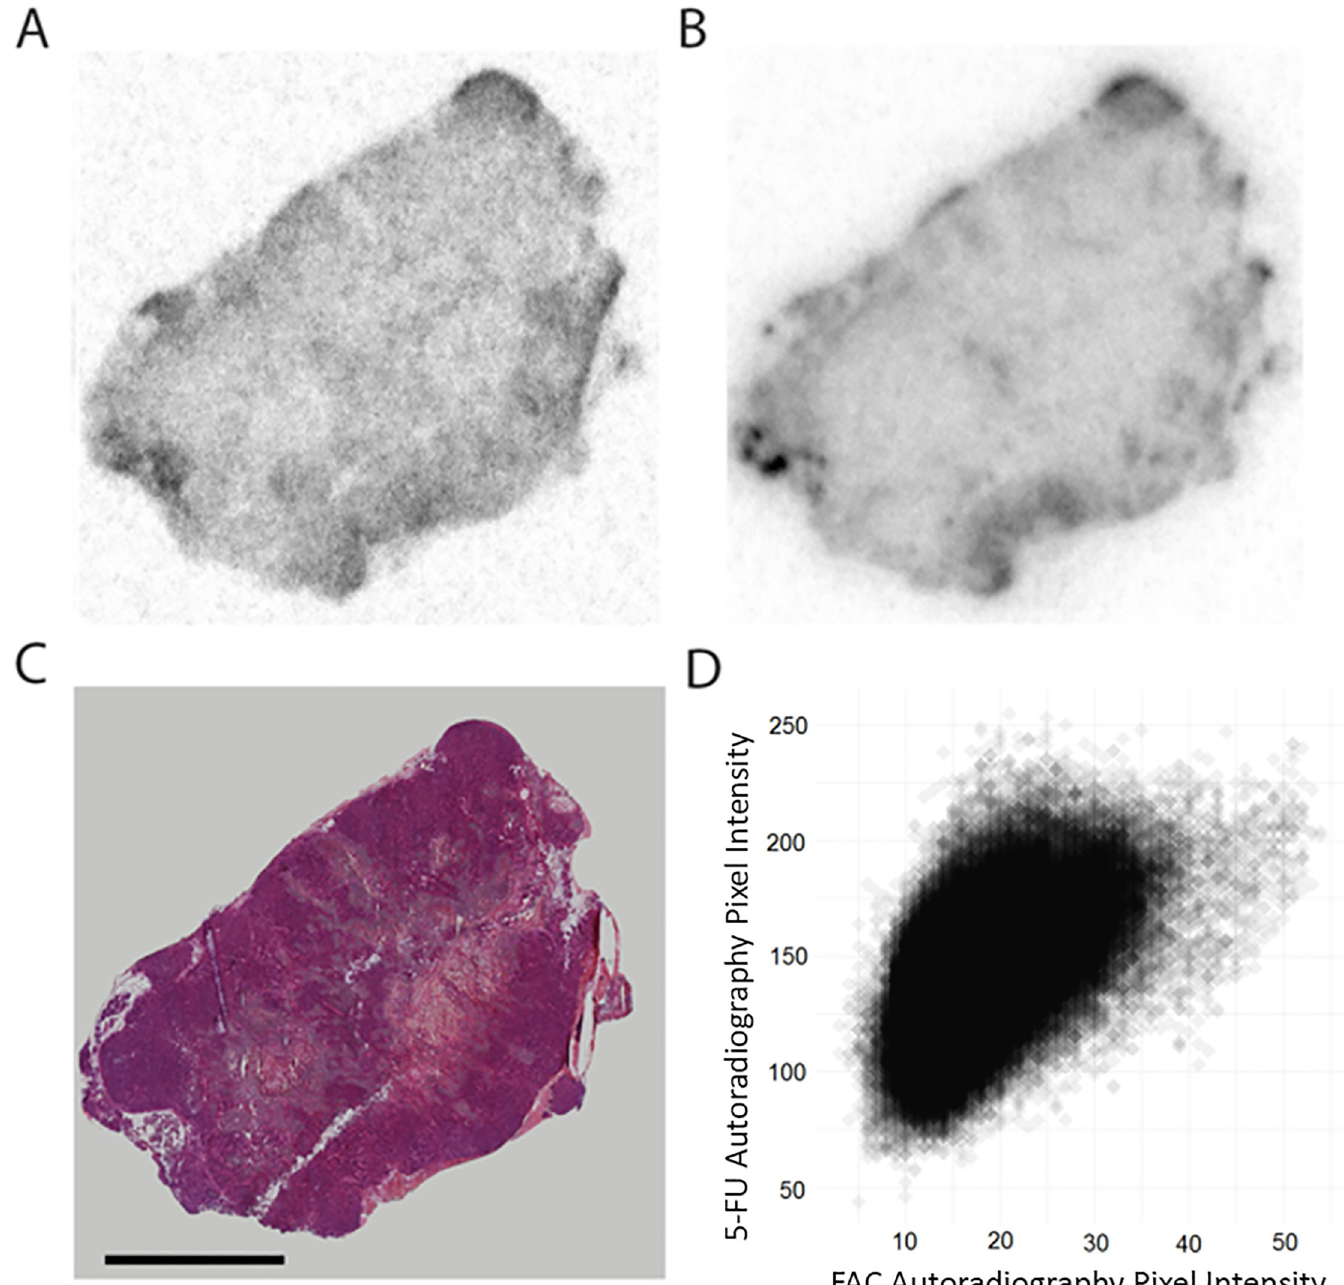
Fig 4. 5-FU and FAC intra-tumoral distribution. Autoradiography of [ 14 C]-5-FU (A) and of [ 18 F]-FAC (B) in an organoid tumor section. H&E staining of that tumor section (C). Scale bar = 5 mm. Scatter plot of the pixel-to-pixel comparison for [ 18 F]-FAC and [ 14 C]-5-FU autoradiography signal (D).